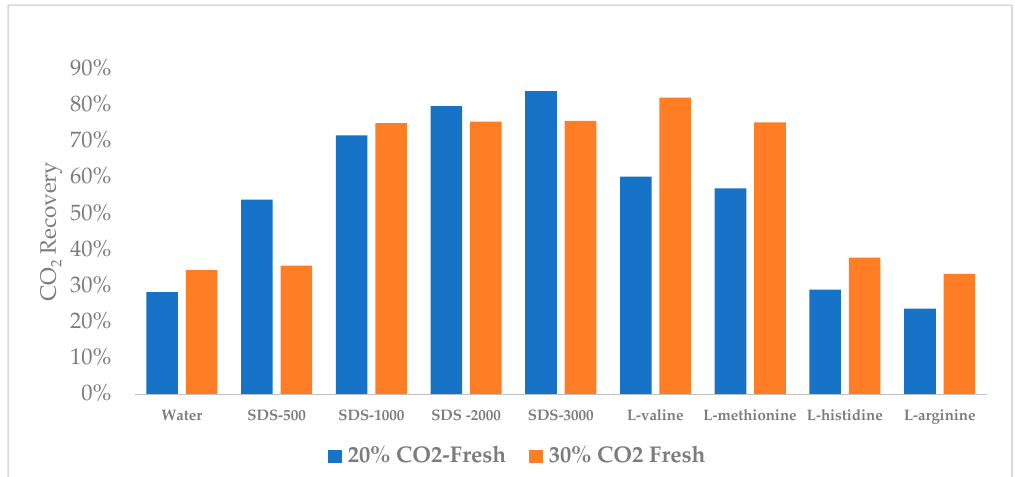
Figure 8. Effect on CO 2 recovery % due to the change in CO 2 concentration in the Flue gas. Change in CO 2 recovery % for surfactant and selected amino acids due to change in CO 2 mole % in the feed gas, measured during an isothermal experiment conducted at 120 bar, 1 °C.